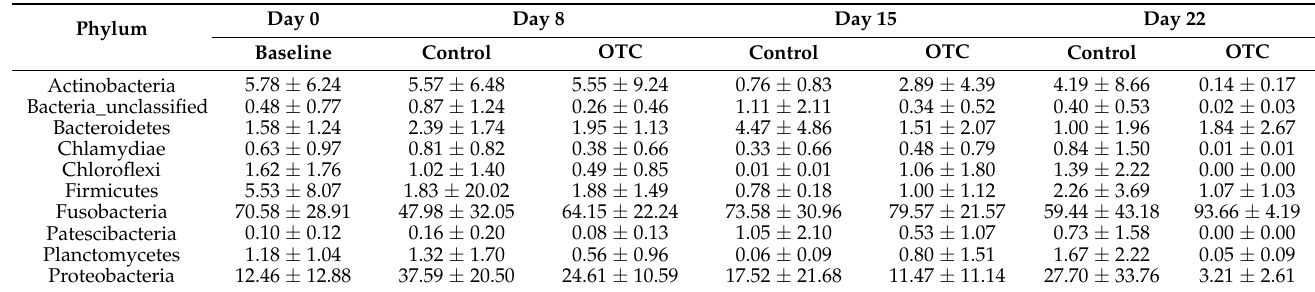
Table 2. Mean ( ± SD) abundance of top bacterial phyla in the distal gut of control or oxytetracycline (OTC)-treated Nile tilapia before and after antibiotic